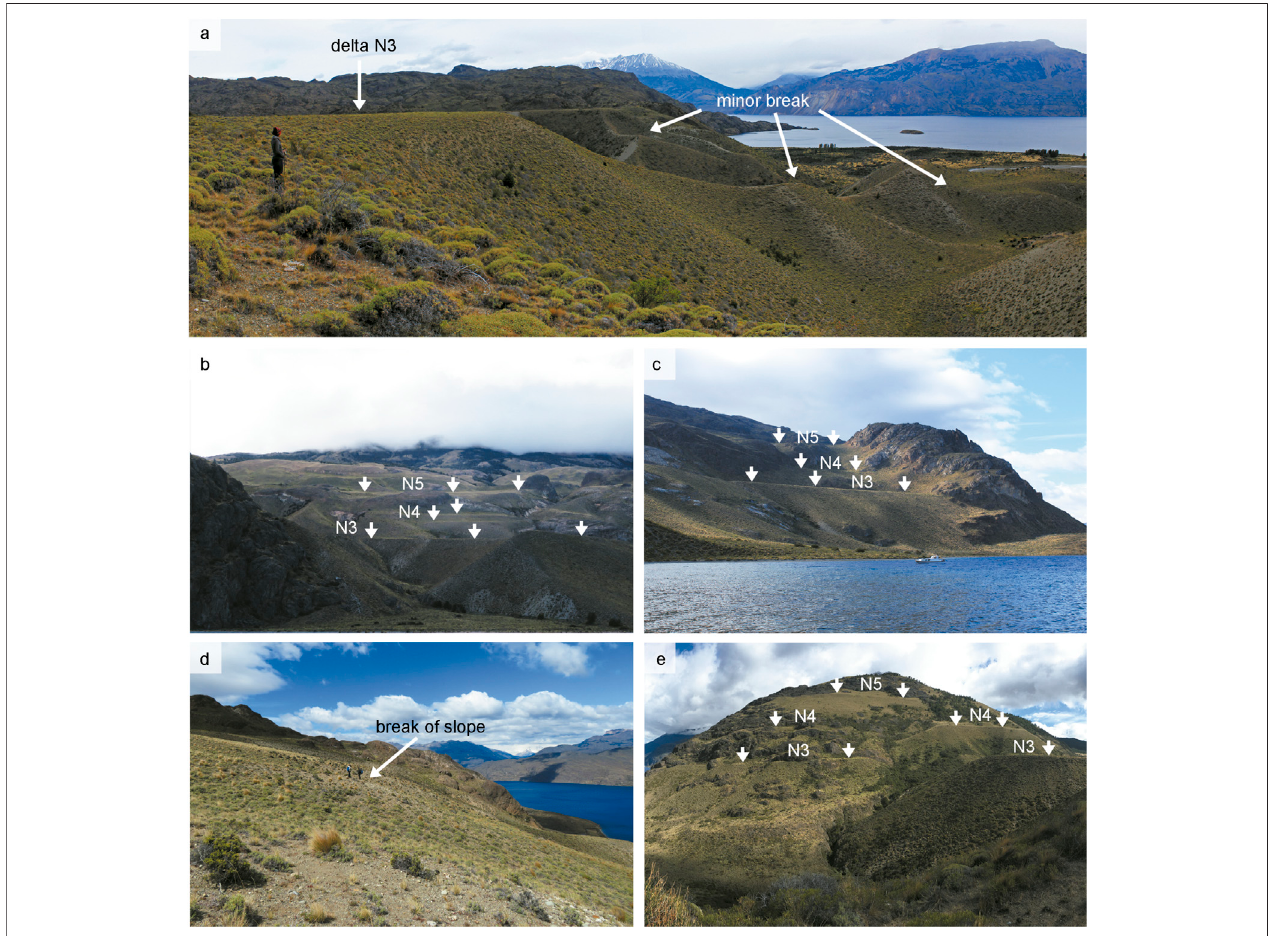
FIGURE 8 | Field photographs from the Río Brown (A) and Paso La Leona sectors (B – E) . See location in Supplementary Figure S7 .